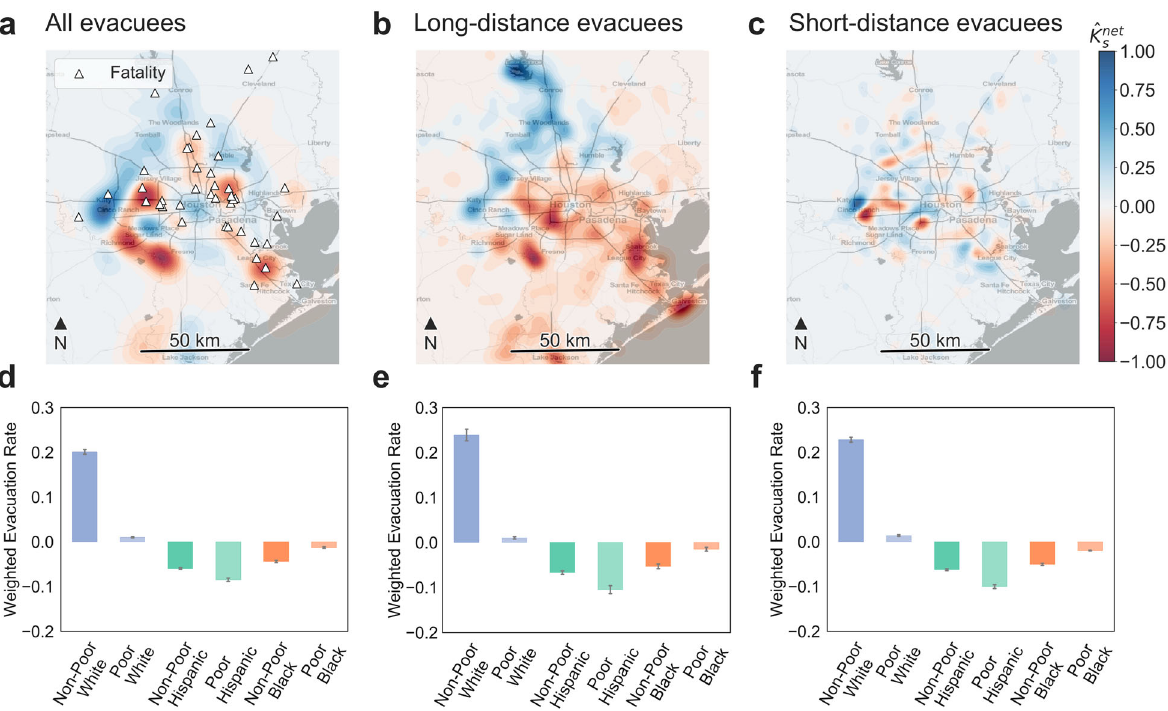
Fig. 1 Geographical and socio-demographic information on evacuation from Hurricane Harvey. a – c Illustrate the net evacuation intensity of each 100 × 100 m grid, de fi ned as the difference b K net s ¼ b K post s (cid:2) b K pre s , where b K post s